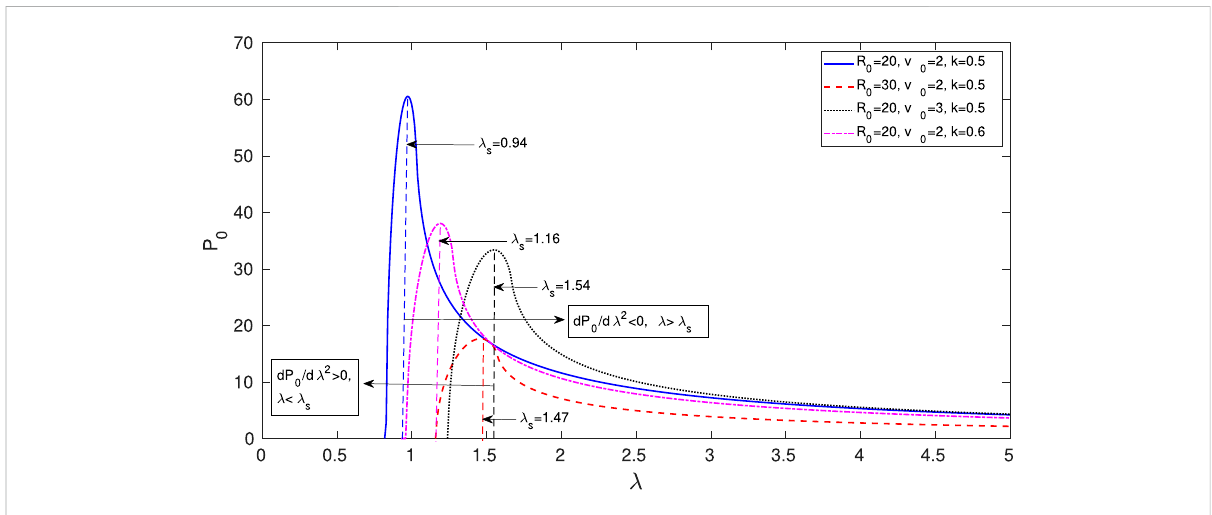
FIGURE 3 Thesolitonphotonnumber P 0 ( λ )isplotted against theeigenfrequency λ with a fi xed α =0.01 andfor differentvalues oftheotherparameters as in the legends. The solitons are stable (unstable) in the regions λ < λ s , dP 0 / d λ 2 > 0 ( λ > λ s , dP 0 / d λ 2 < 0).